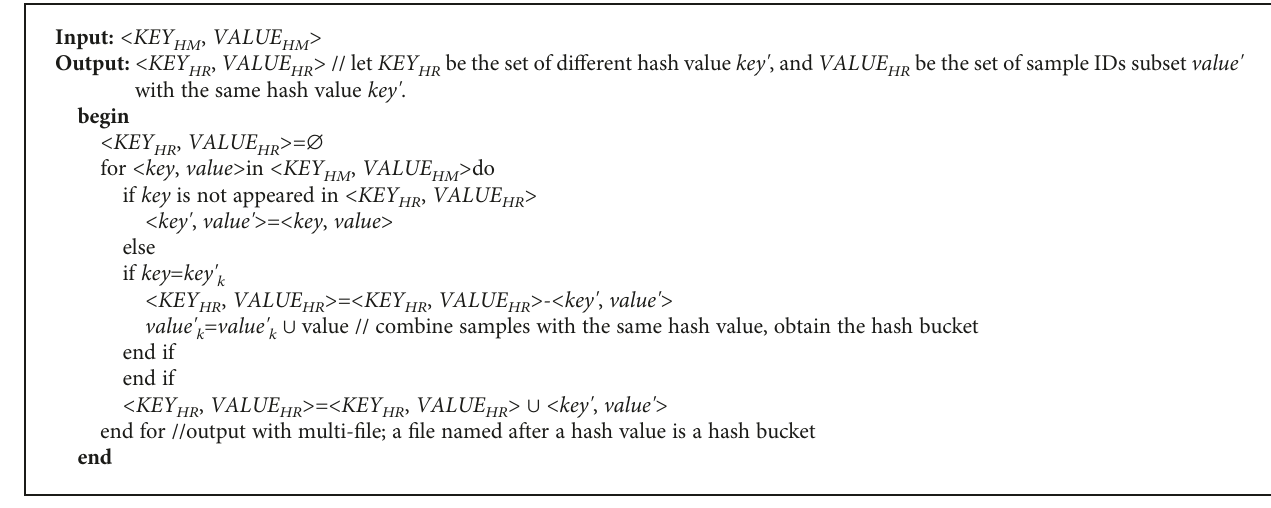
Algorithm 2: Hash-Reduce